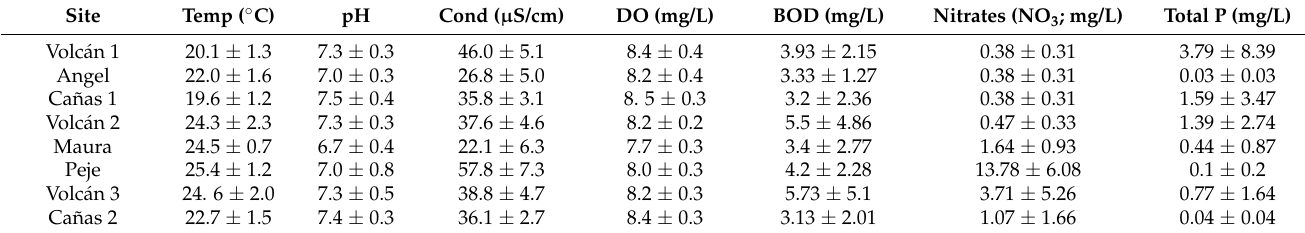
Table 3. Mean and standard deviation (mean ± standard deviation) of physical, chemical, and nutrient parameters in the Volc á n River watershed, period 2011–2013.